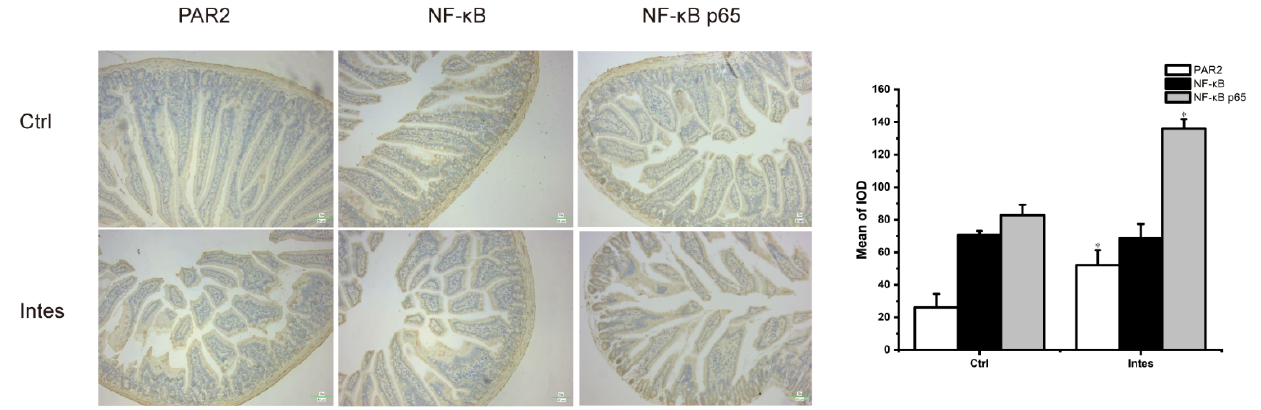
Figure 10. Immunohistochemical pictures and quantitative analysis of PAR2 and NF- κ b in the gut microbiota dysbiosis model. * p < 0.05 as compared to the OVA-Antibiotic- group.